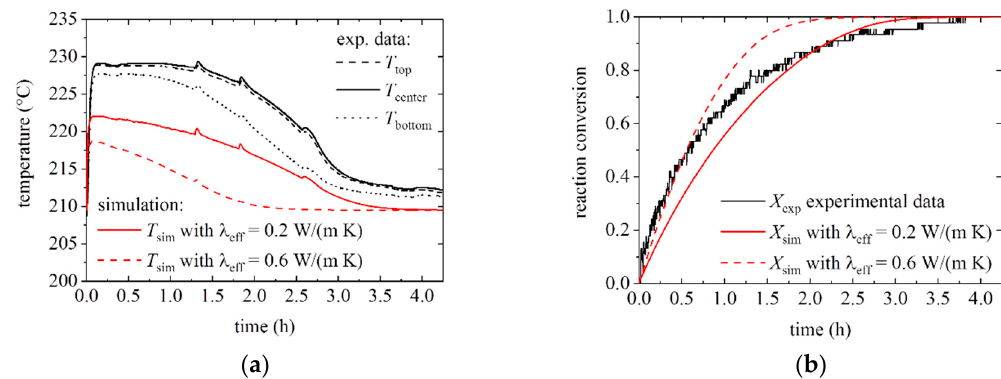
Figure 5. Experimental and simulation results for 209.5 °C discharge temperature and 90 °C evaporation temperature. The simulation study is based on the pressure curve measured in the experiment. ( a ) Temperature profile and ( b ) reaction conversion.